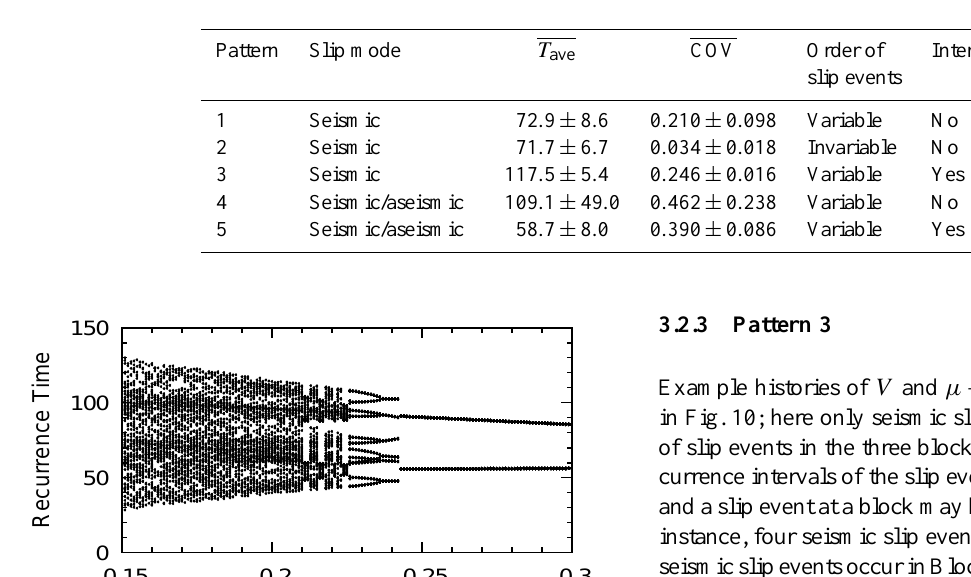
Figure 6. Example histories of (a) V and (b) µ − µ ∗ for pattern 1. The model parameters are set to K = 1 . 00, P 1 = 0 . 450, P 2 = 0 . 100, and P 3 = 0 . 200. Table 1. The slip mode, the average value of the recurrence interval T ave and the coefficient of variation COV, the order of slip events in the three blocks, and the intermittency of the slip pattern for the five slip patterns. Data for seismic slip events in Block 2 for all cases categorized into each complex slip pattern are used for T ave and COV. See text for details of calculation.